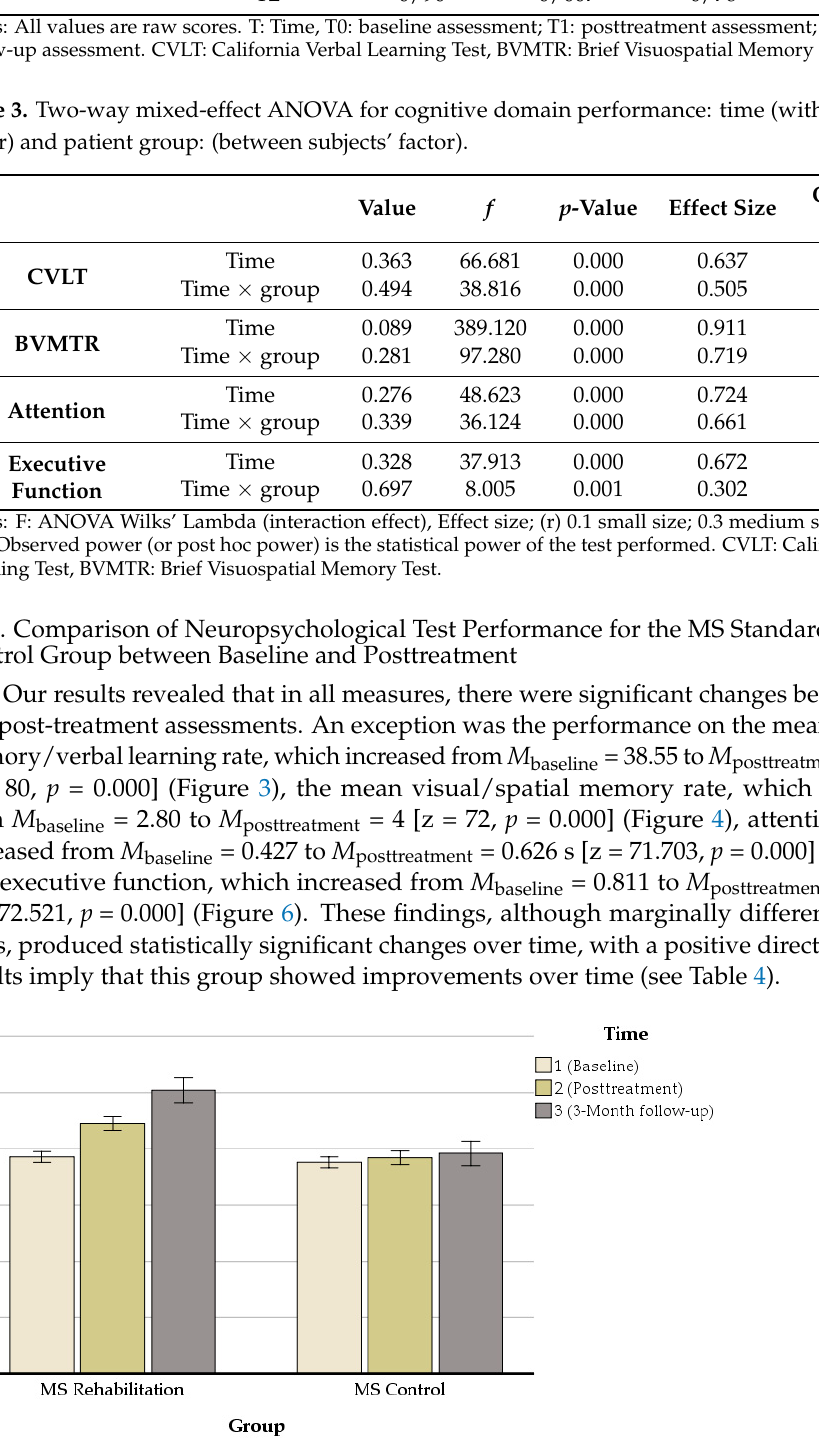
Table 3. Two-way mixed-effect ANOVA for cognitive domain performance: time (within subjects’ factor) and patient group: (between subjects’ factor).